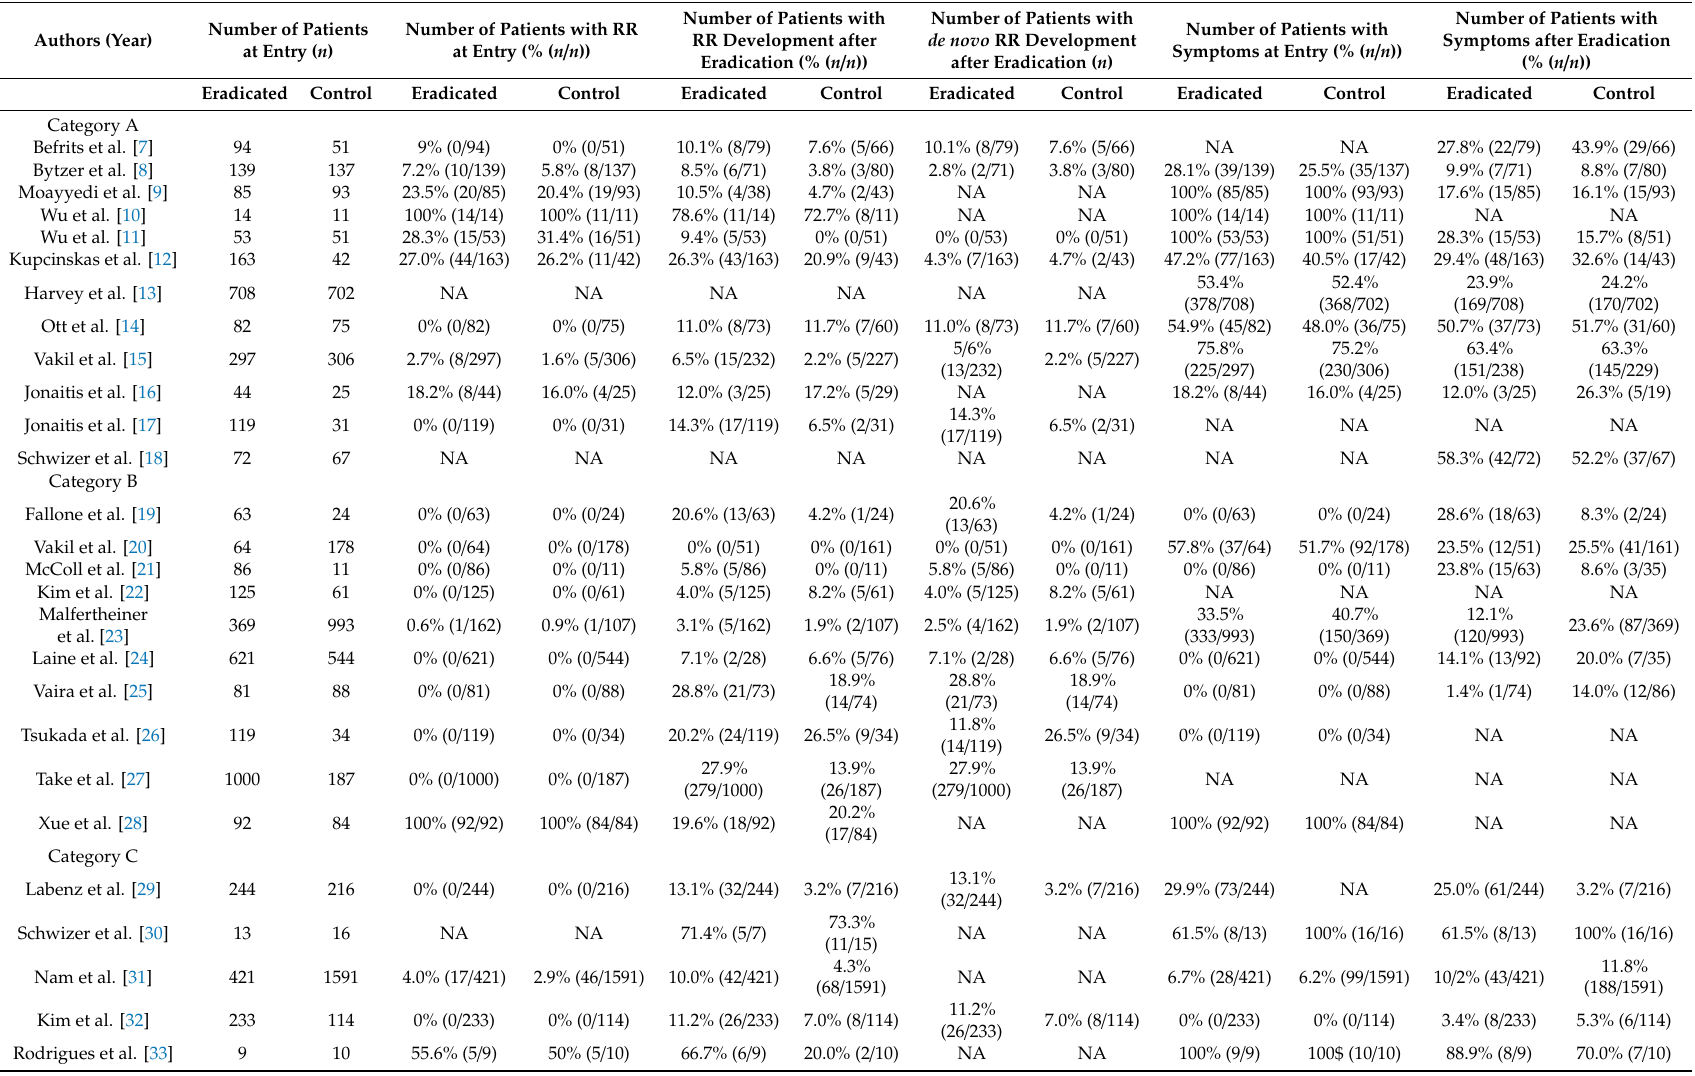
Table 2. Development of erosive esophagitis and reflux-related symptoms after Helicobacter pylori eradication